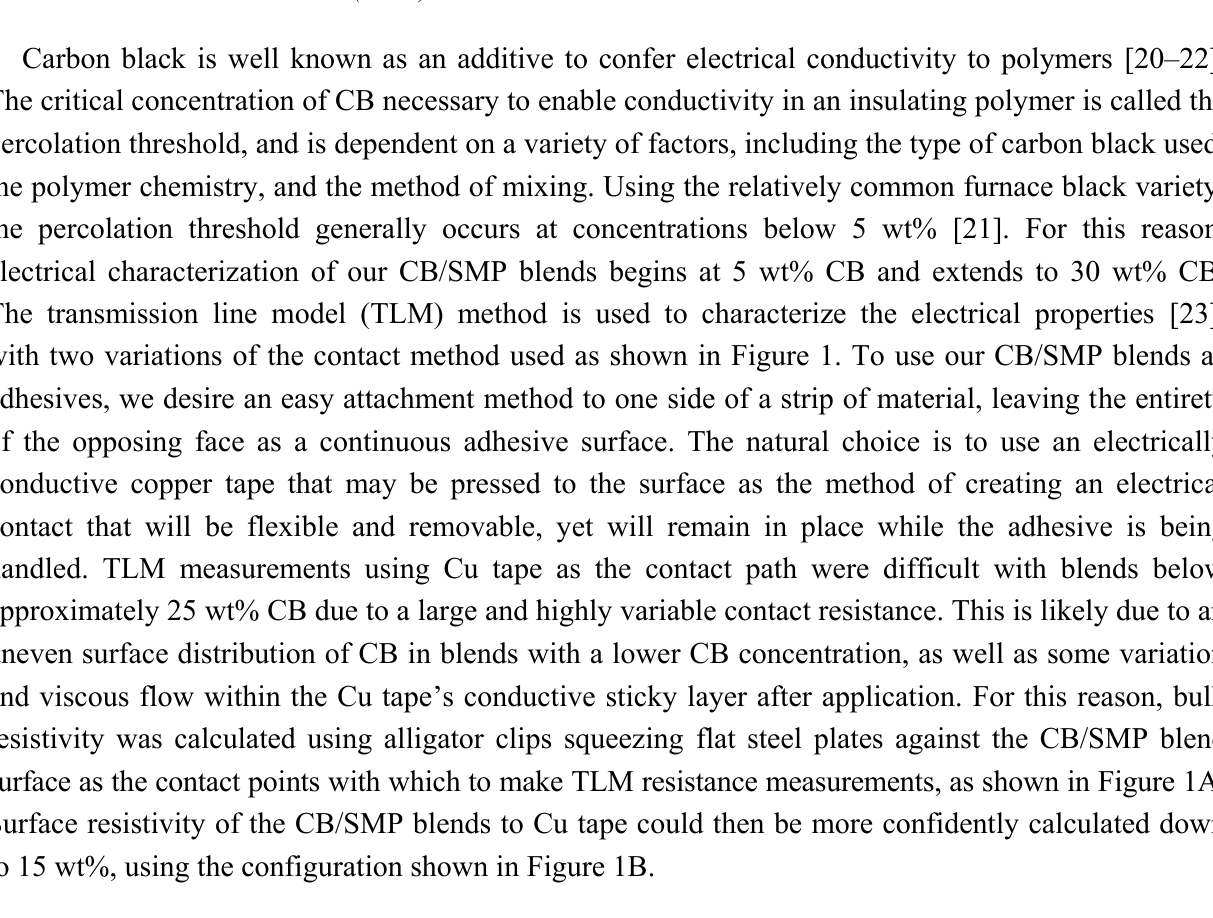
Figure 1. Transmission line model (TLM) data is collected using ( A ) the steel clip method and ( B ) the Cu tape method. The steel clip method yields more consistent data for mixtures with low weight percentage of carbon black